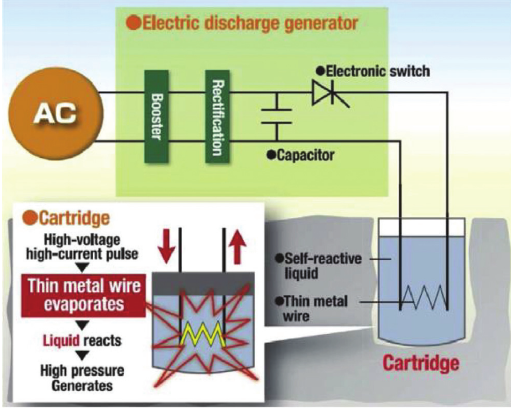
Figure 4: The shock pressure caused by HVPD.